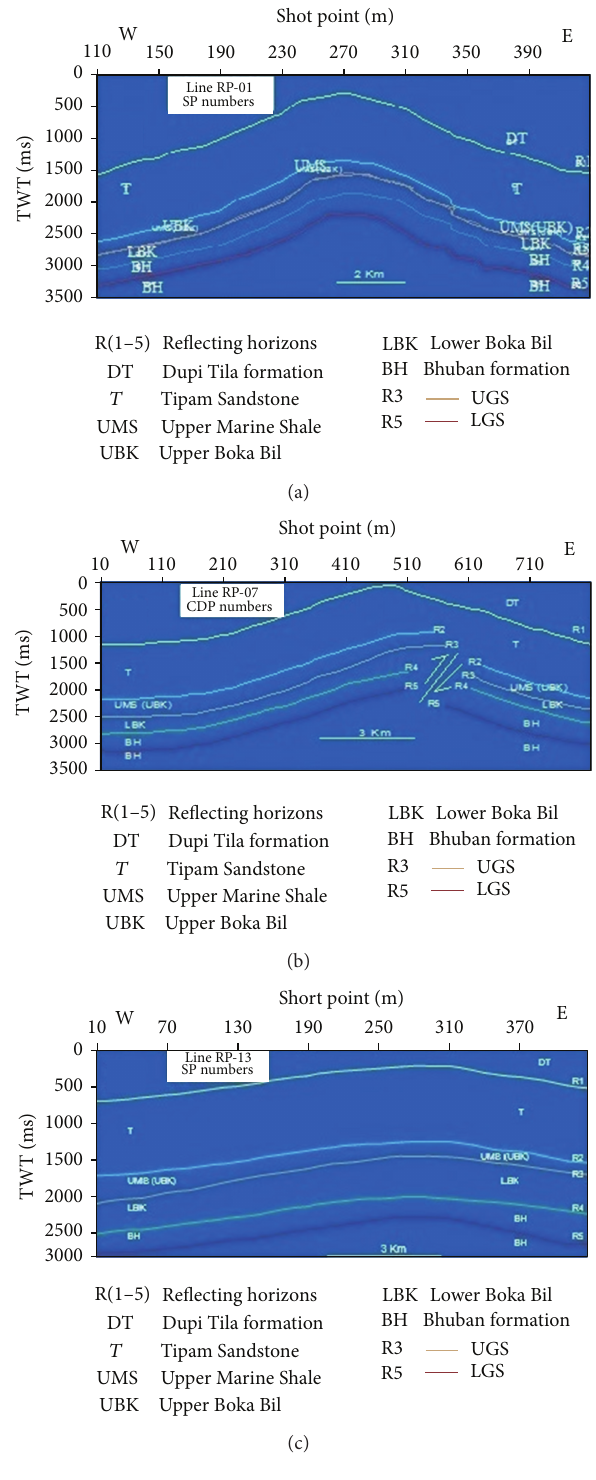
Figure 3: Geologic interpretation of seismic sequences along the seismic sections in the structure, (a) Seismic line RP-01, (b) Seismic line RP-07, and (c) Seismic line